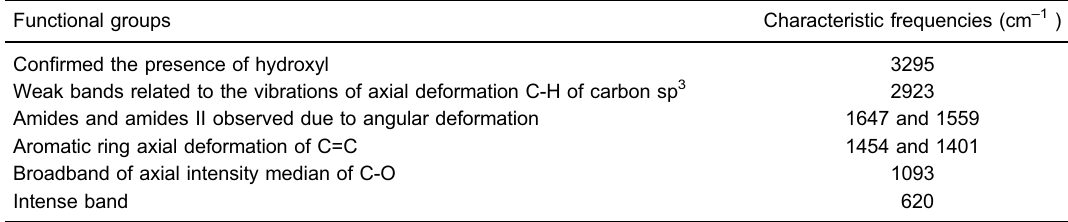
Table 4. Characteristic spectral peaks analysis of biosurfactant produced by Streptomyces sp. DPUA1559 by ATR-FTIR. Functional